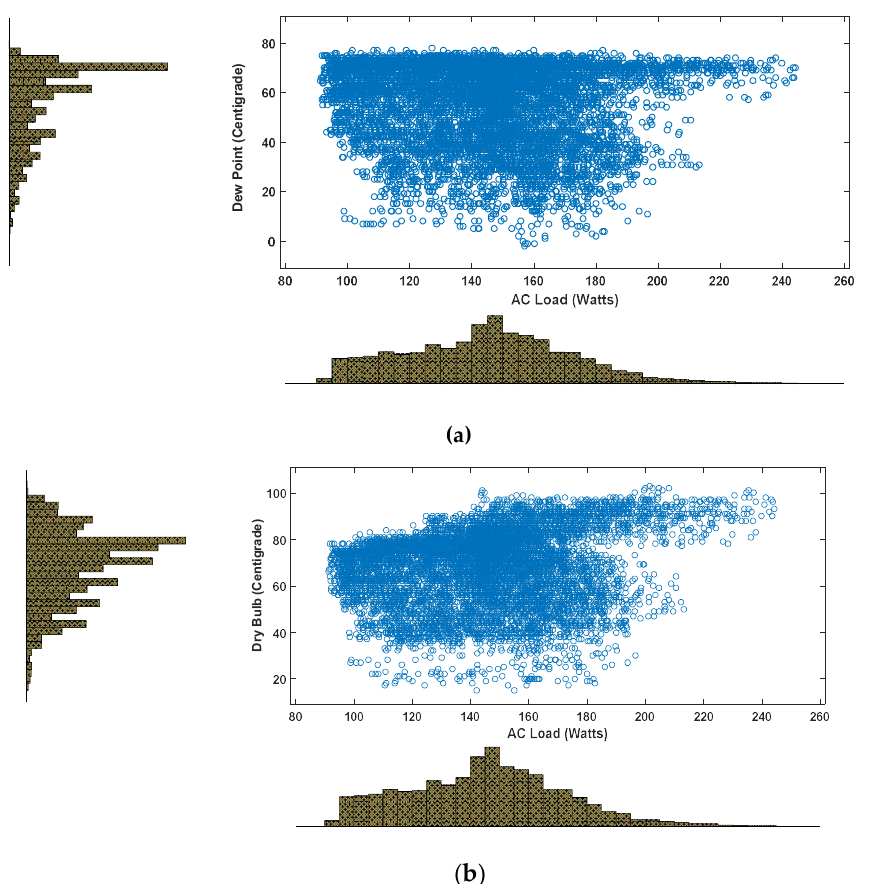
Figure 4. AC Load variations due to ( a ) Dew Point Temperature ( b ) Dry Bulb Temperature.